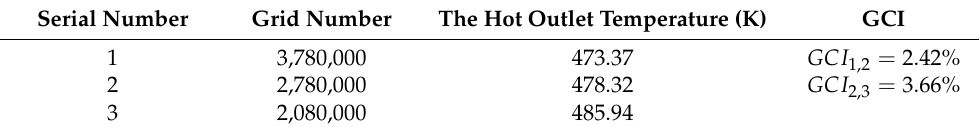
Table 3. The grid independence verification by grid convergence index